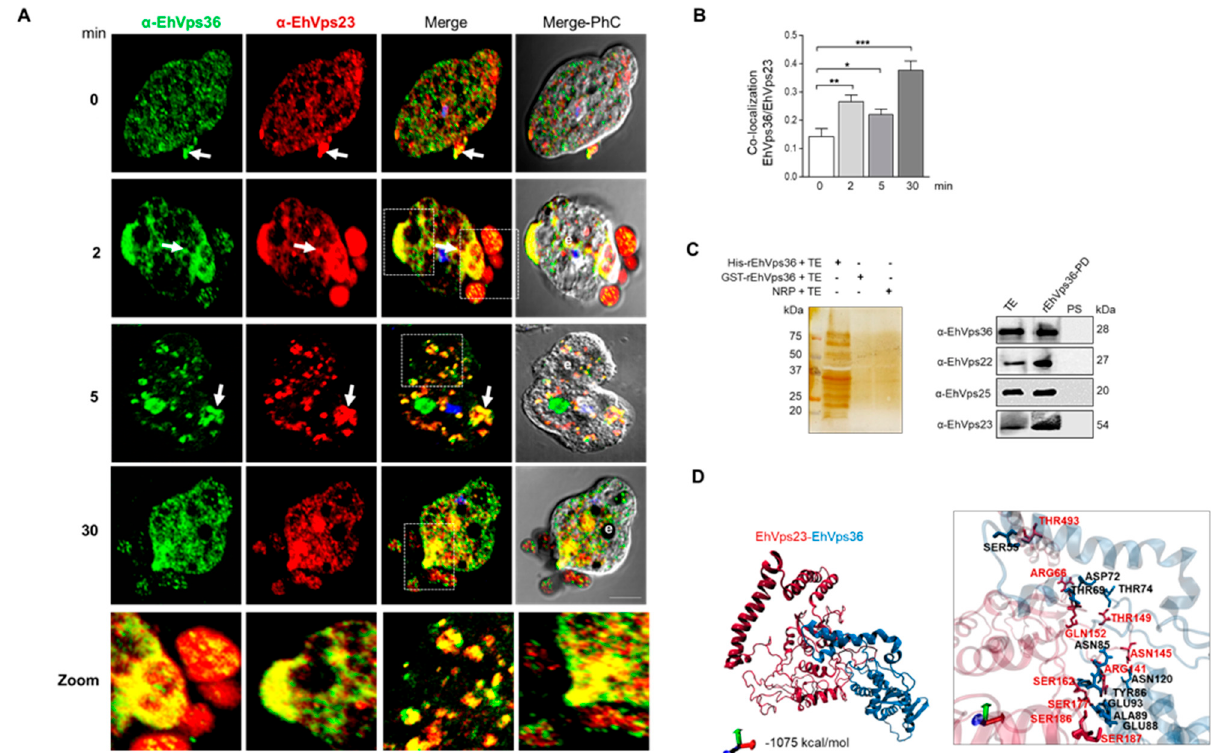
Figure 6. Cellular co-localization of EhVps36 (ESCRT-II) and EhVps23 (ESCRT-I) during phagocytosis. ( A ) Confocal images of trophozoites treated with α -EhVps36 (green) and α -EhVps23 (red) antibodies. The nucleus was stained with DAPI (blue). PhC: phase contrast images. Arrows: co-localization of the proteins. Zoom: magnification of the regions marked with white squares. Bar = 10 µm. ( B ) Pearson’s coefficient of co-localization of EhVps36 and EhVps23 (*) p < 0.05, (**) p < 0.01 (***) p < 0.001. ( C ) Left panel: silver-stained gel of the samples obtained from the pull-down assay and negative controls. TE: total extracts; NRP: non-recombinant protein. Right panel: western blot assay of pull-down assays using α -EhVps36 for precipitation and α -EhVps22, α -EhVps25, and α -EhVps23 antibodies to detect the associated proteins. rEhVps36-PD: pull-down sample PS: pre-immune serum. Numbers to the right: molecular weights. ( D ) Molecular docking between EhVps36 and EhVps23. The inset shows a magnification of the predicted amino acids involved in protein–protein